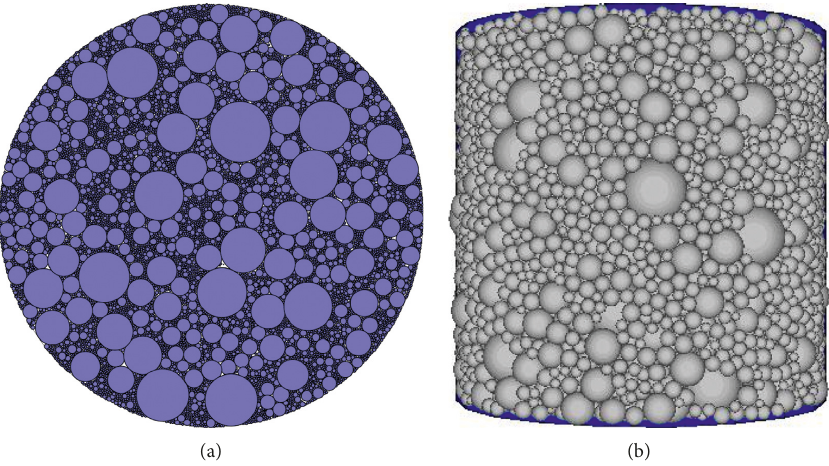
Figure 4: Splitting test sample divided into discrete elements. (a) Two-dimensional disk specimen. (b) Three-dimensional sphere specimen